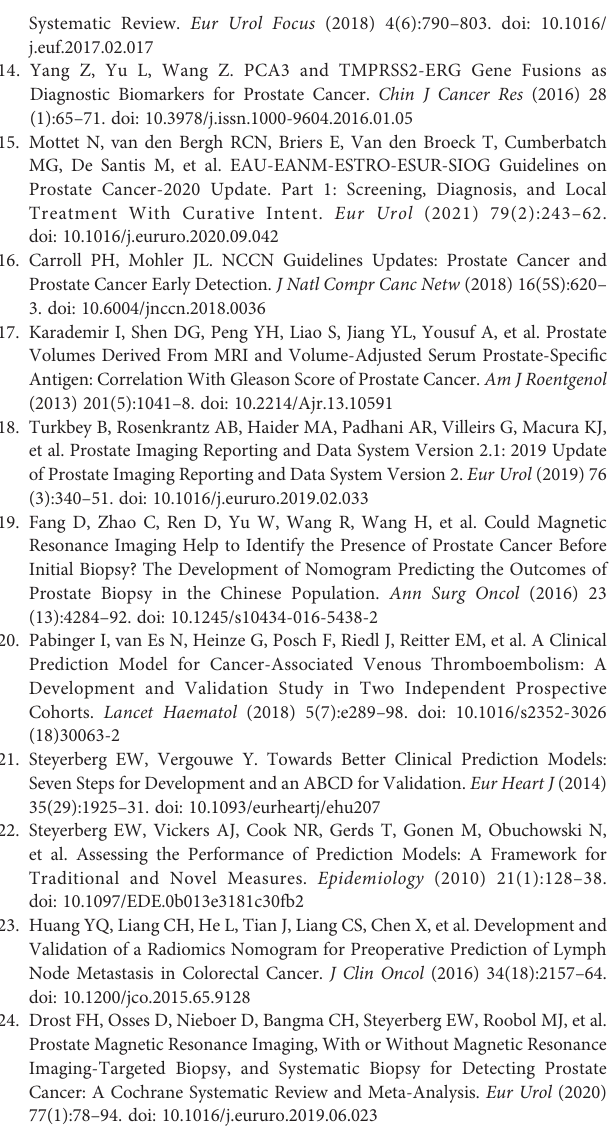
discrimination. (D, E, and F) Calibration plots of the three groups for assessing the calibration. Supplementary Figure 6 | External validation of the nomogram in the DF cohort for three PSA groups. (A, B, and C) The ROC curve of the three groups for assessing the discrimination. (D, E, and F) Calibration plots of the three groups for assessing the calibration. Supplementary Figure 7 | External validation of the nomogram in the ZD cohort for three PSA groups. (A, B, and C) The ROC curve of the three groups for assessing the discrimination. (D, E, and F) Calibration plots of the three groups for assessing the calibration. Supplementary Table 1 | Univariate and multivariate analysis for screening the predictors of outcomes (csPCa) of prostatic biopsy. csPCa, clinically signi fi cant prostate cancer; BMI, body mass index; PSA, prostate-speci fi c antigen; PSAD, prostate-speci fi c antigen density; PI-RADS, prostate imaging-reporting and data system; OR, odds ratio; CI, con fi dence